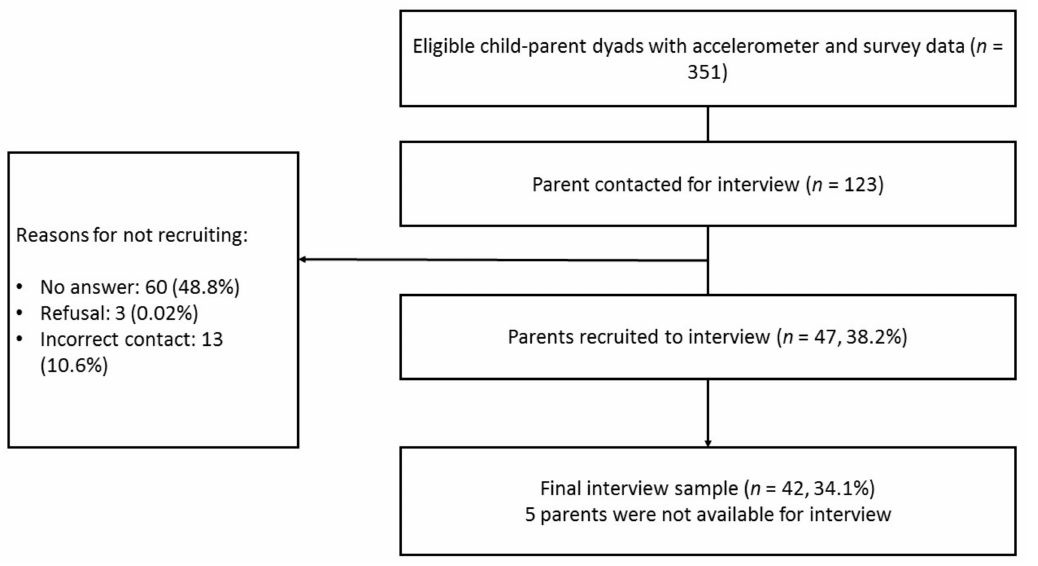
Figure 1. Study flow of